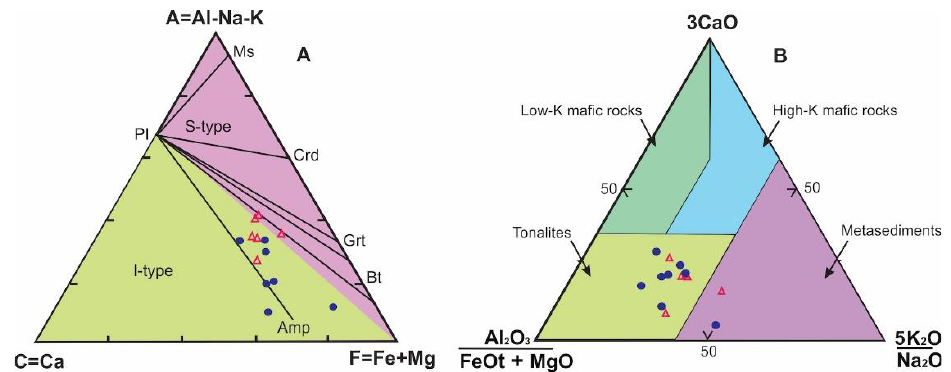
Figure 10. ( A ) Plots of the Wadhrai granite analyses on ( A ) mole% ACF diagram, showing the fields for S- and I-type granitoids [26]. ( B ) 3CaO–(5K 2 O/Na 2 O)–Al 2 O 3 /(FeOt + MgO) diagram showing fields representing the composition of melts derived from a range of potential sources [59]. Symbols as in Figure 4.